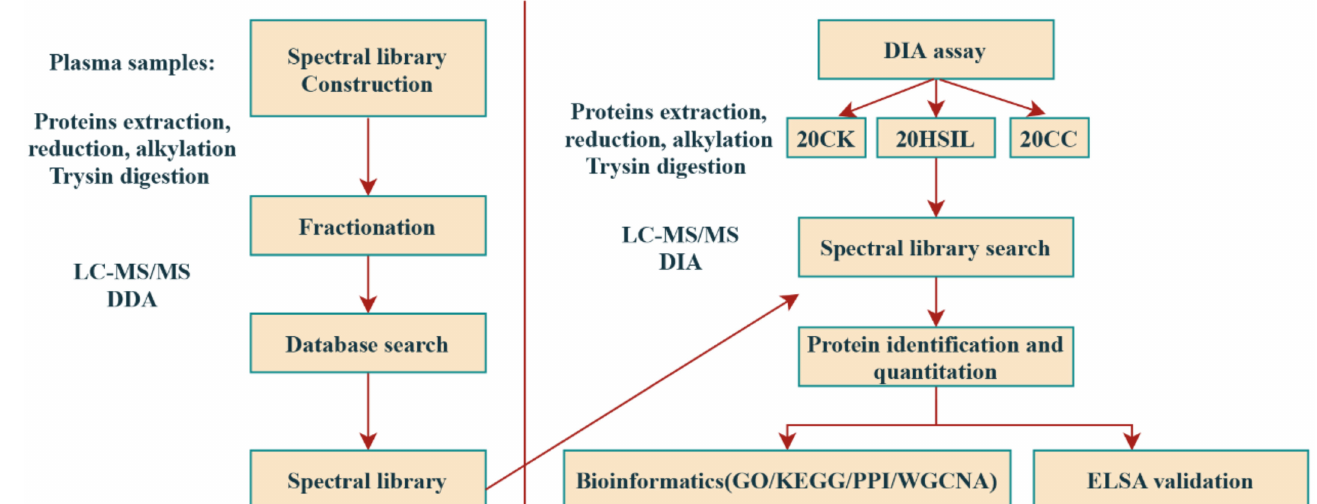
Figure 1. DIA experimental and analytic